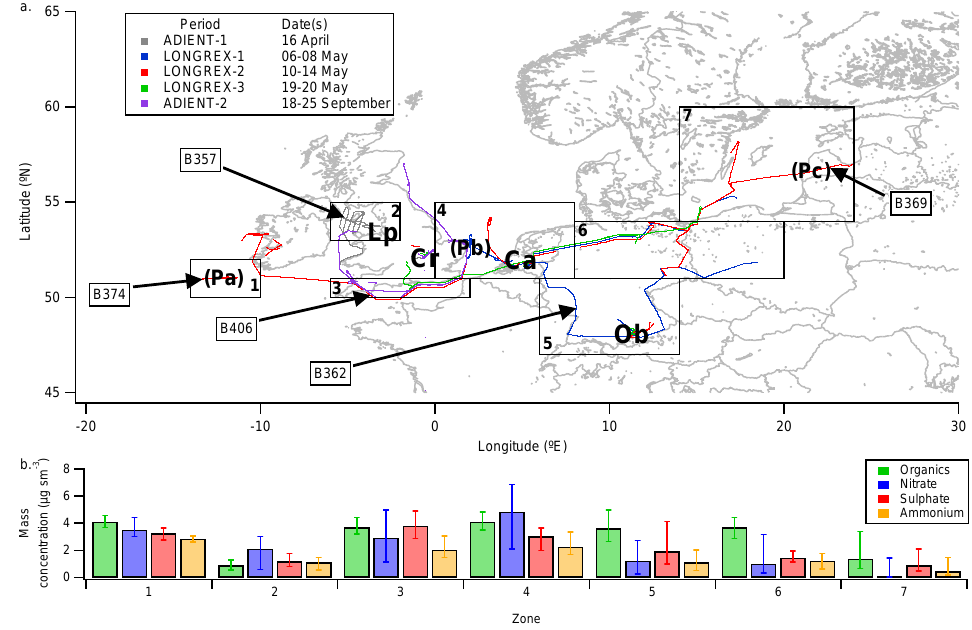
Fig. 1. (a) Flight tracks of the BAe-146 considered by this analysis for segments below 3000m. The periods identified in the figure are described in the main text and Table 1. Overlapping flight tracks are offset slightly in order to clearly discern them. The flight numbers and arrows refer to the example flights discussed in the main text. Locations relevant to this study are marked, including Liverpool (Lp), Cranfield (Cr), Cabauw (Ca) and Oberpfaffenhofen (Ob). The locations of the vertical profiles displayed in Fig. 3 are indicated by the Pa (Profile-a), Pb (Profile-b) and Pc (Profile-c) markers. (b) Summary of the AMS median mass concentrations for each zone identified in (a) . The vertical bars represent the 25th and 75th percentiles.The percentile concentrations are included in the Supplementary materials in Table S3